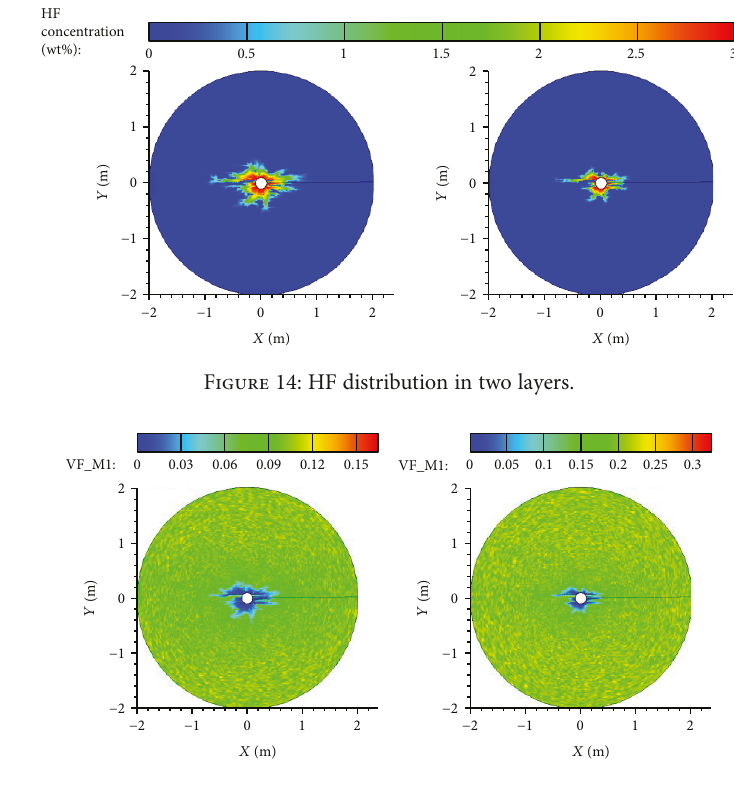
Figure 15: Fast-reacting mineral distribution in two layers.